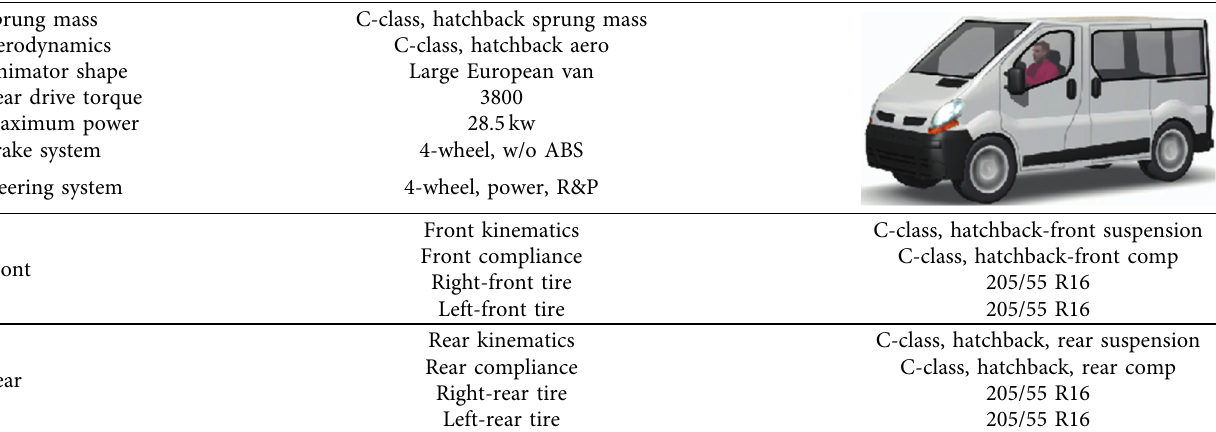
Table 5: Model of small electric power passenger vehicle.